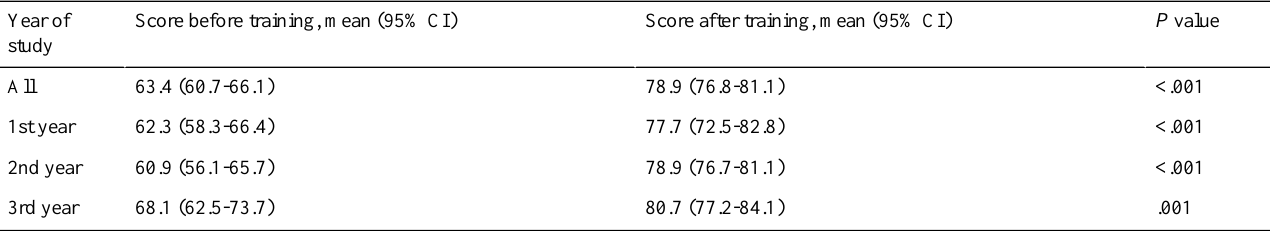
Table 2. Mean scores of senior house officers on the knowledge test.